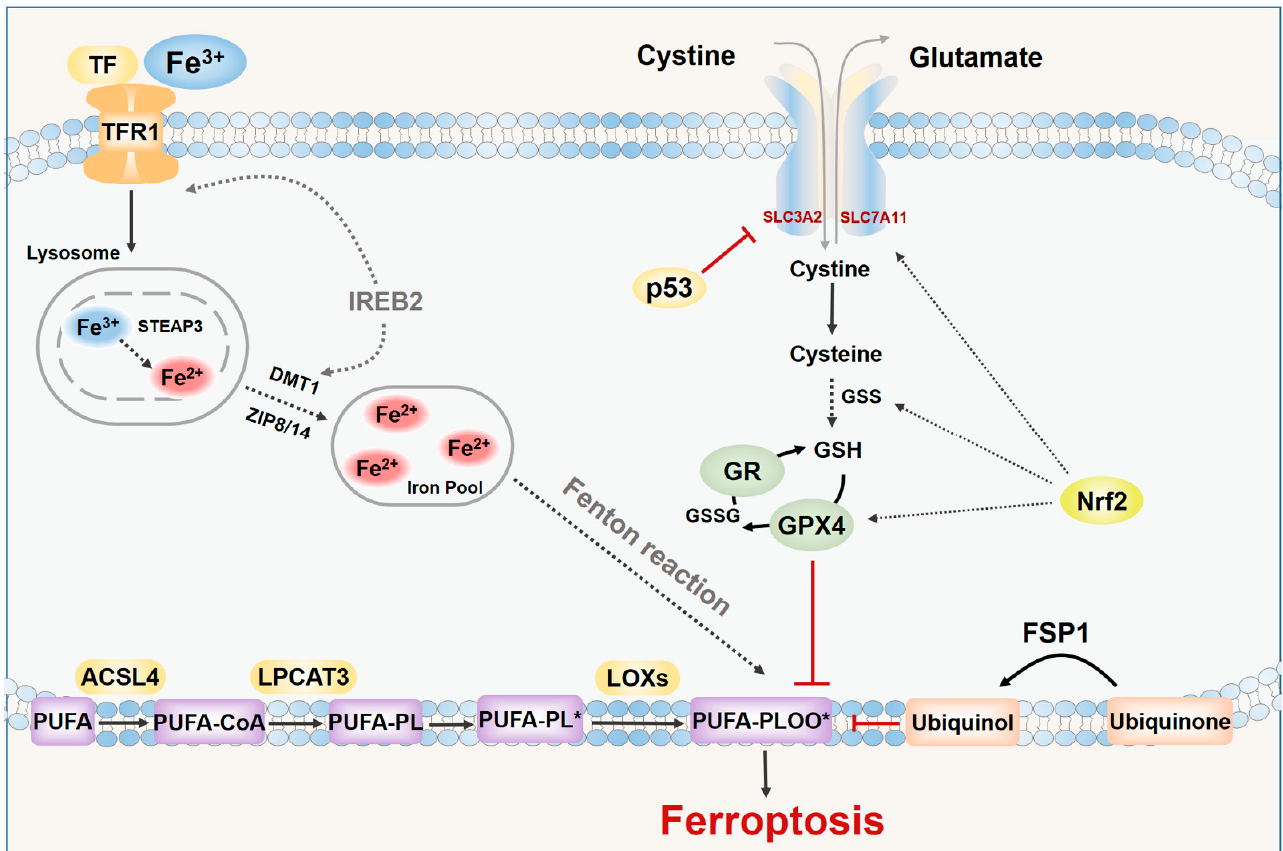
Figure 1. The mechanism of ferroptosis. The figure shows the related molecules and pathways of ferroptosis. Ferroptosis is caused by the inhibition of the system Xc − /GSH/GPX4 axis or the accumulation of Fe 2+ and lipid peroxidation. Regulators of iron metabolism, including TF, TFR1, and ferritinophagy, regulate ferroptosis by enhancing the labile iron pool ‐ mediated Fenton reaction, and FSP1 can negatively regulate ferroptosis through CoQ10, thereby inhibiting the delivery of lipid peroxides. Abbreviations: ACSL4, acyl ‐ CoA synthetase long ‐ chain family member 4; DMT1, divalent metal transporter 1; FSP1, ferroptosis suppressor protein; GPX4, glutathione peroxidase 4; GR, glutathione ‐ disulfide reductase; GSH, glutathione; GSS, GSH synthetase; GSSG, oxidized glutathione; IREB2, iron responsive element binding protein 2; LPCAT3, lysophosphatidylcholine acyltransferase 3; PUFAs, polyunsaturated fatty acids; STEAP3, six transmembrane epithelial antigen of prostate 3; SLC3A2, solute carrier family 3 member 2; SLC7A11, solute carrier family 7 member 11; TF, transferrin; TFR1, transferrin receptor 1; ZIP8/14, zinc/iron regulatory protein family 8/14. PUFA ‐ PL*, polyunsaturated fatty acid ‐ phospholipid radical; PUFA ‐ PL ‐ OO*, polyunsaturated fatty acid ‐ phospholipid ethanolamine peroxyl radical. Black arrows indicate the activation modification, and red block lines indicate inhibitory modification. Black dashed arrows indicate the indirect process. Double arrows indicate the reverse transport process of glutamate and cystein.